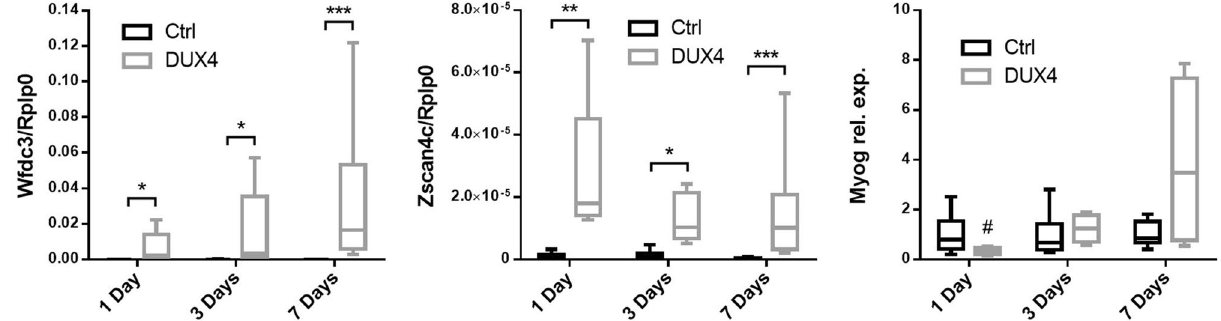
Figure 8. RTqPCR analyses of DUX4 target genes ( Wfdc3, Zscan4c ) and Myog expression level in TA muscle. TAs were injected by hIMEP with either 1 µg of control pCIneo DNA, 1 µg of pCIneo-DUX4 - or with 50 µl of saline solution and harvested 1-, 3- or 7-days post injection. Total RNA was extracted with Trizol and qPCRs were performed in duplicates using SYBR Green FastStart Essential DNA Green Master. Analyzes were performed with LightCycler 96 software. At each time, results obtained from control plasmid and saline solution injected groups were pooled to form a single control group, as no statistical difference could be highlighted between them for all tested genes (one-way ANOVA on the ranks followed by Dunn’s post hoc test). Results are presented as fold difference to Rplp0 for Wfdc3 and Zscan4c and as relative to control for Myog . All data are presented as boxplots, *p < 0.05, **p < 0.01, ***p < 0.001 and # p < 0.05 vs DUX4 7 days, One-way ANOVA